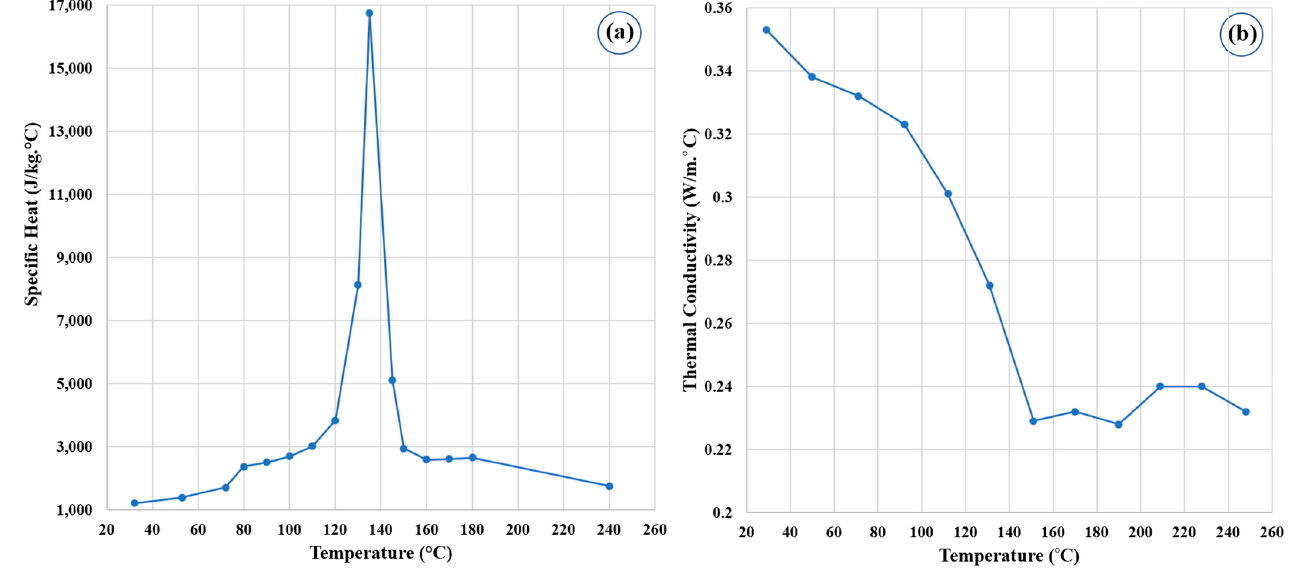
Figure 1. ( a ) Specific heat and ( b ) Thermal conductivity of HDPE.